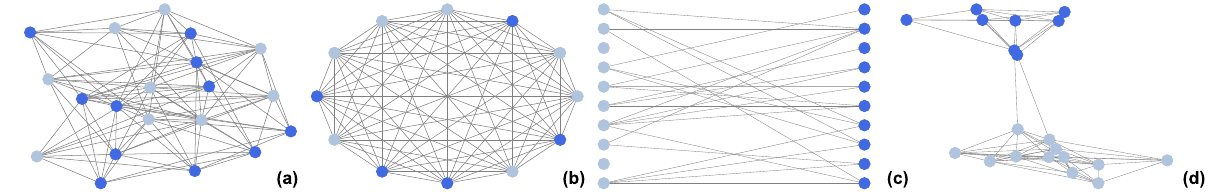
Fig. 2 Networks generated by different linking probability p in the weighted multifractal graph model (WMGM). By choosing p , the WMGM can control the topology of generated networks. a p = [0.5, 0.5; 0.5, 0.5]. b p = [1, 1; 1, 1]. c p = [0.01, 0.2; 0.2, 0.01]. d p = [0.8, 0.02; 0.02,